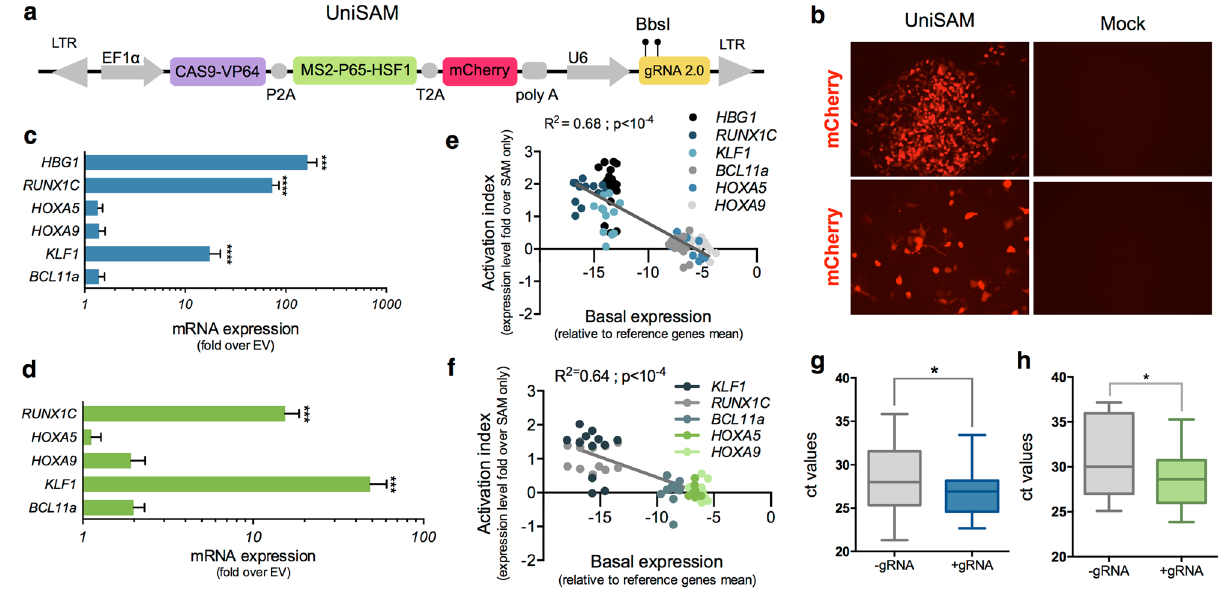
Figure 1. Design and assessment of all-in-one UniSAM vectors in HEK293T and HeLa cells. ( a ) Schematic of UniSAM vector in PiggyBac backbone. ( b ) Expression of mCherry in HEK293 and HeLa cells demonstrates efficient transfection and expression of the UniSAM vector. ( c ) Activation of five transcription factors and HBG1 following transfection of UniSAM vectors carrying single gRNAs, in HEK293T cells. ( d ) Activation of five transcription factors with single gRNAs, in HeLa cells. Data in ( c ) and ( d ) represent the mean activation by 4–6 single gRNAs for each gene (n = 3, Mann Whitney t-test). ( e , f ) Relationship between basal expression and activation levels for the different genes in HEK293T ( e ) and HeLa ( f ) (n = 72 from 3 independent experiments, linear regression with F-test). ( g , h ) Analyses of variance in Ct values following activation in HEK293T ( g ) and HeLa ( h ) (n = 3, F-test, p <